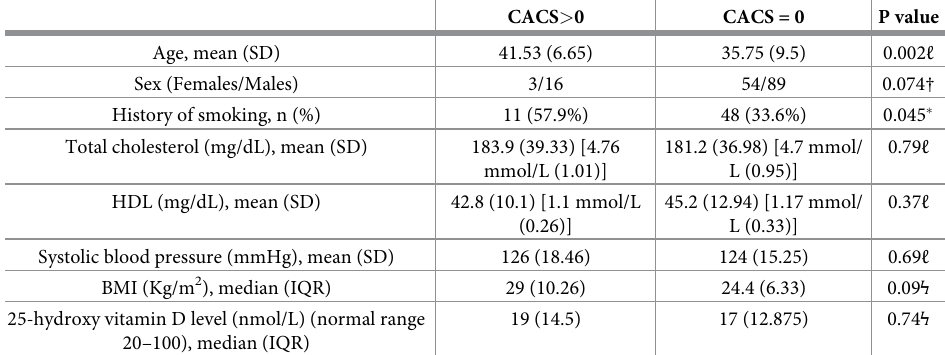
Table 4. Relation between specific factors and presence of coronary